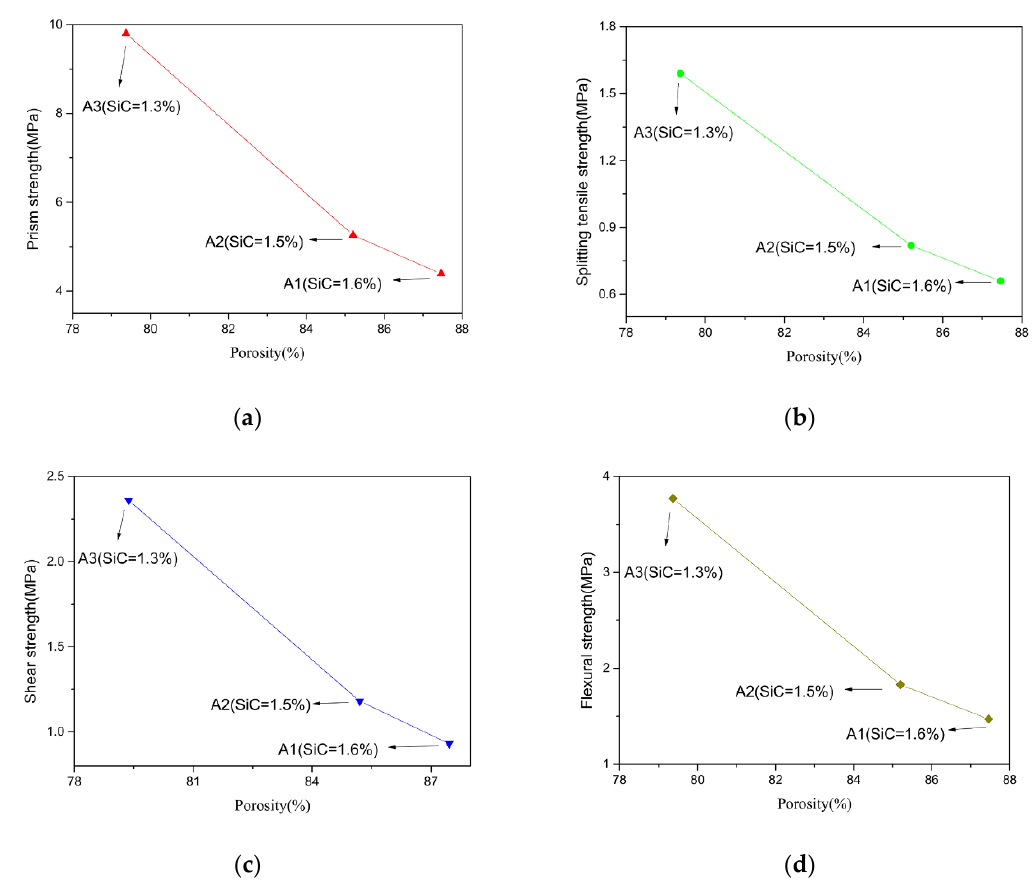
Figure 15. Comparison of the porosity and mechanical properties of group A1, A2, and A3 specimens. ( a ) Comparison of porosity and prism strength; ( b ) Comparison of porosity and splitting tensile strength; ( c ) Comparison of porosity and shear strength; ( d ) Comparison of porosity and flexural strength.